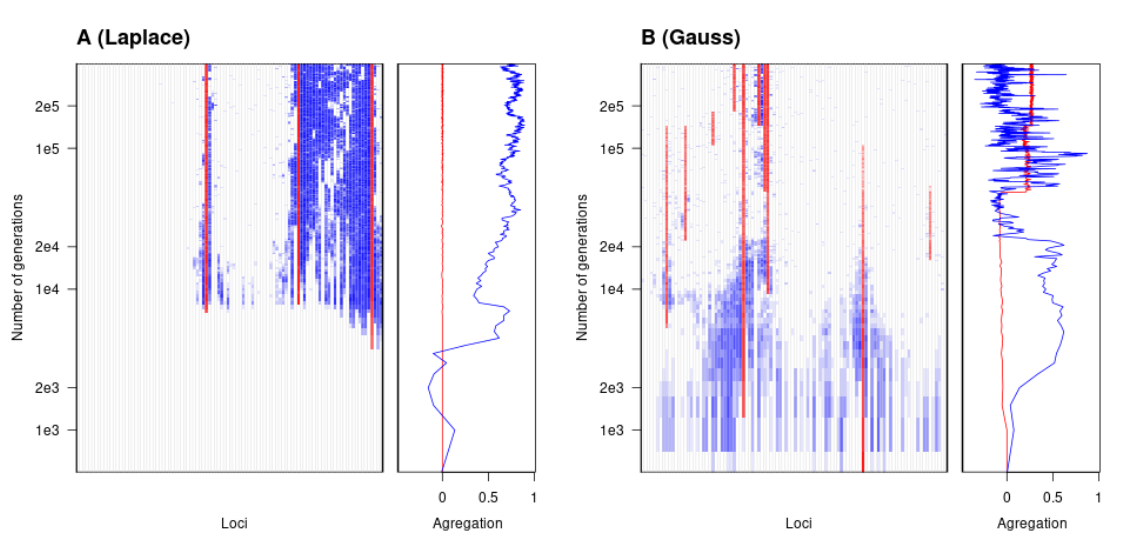
Figure 7 - Typical examples of aggregation dynamics with Laplace (panel A) and Gauss (panel B) fitness functions. In each panel, the frequency of the dominant adaptive allele at each locus within the central deme of habitat 2 is presented, in blue if it is an allele with a small effect size, red if it is a large effect size, with darker color for larger frequency. The x-axis “loci” represent loci, as they are ordered on the chromosome The evolution of the genetic architecture through time can be observed along the y-axis (in log scale, which allows presenting simultaneously the emergence and long term reconfiguration phases). Right next to these maps, we present how the aggregation metrics of small (blue lines) and large effect size alleles (red shapes) change in time. In the two examples, the width of habitat 2 is set to 𝑙 = 19 demes (which is between the swamping limits for small and large effect mutations in the Laplace case, see fig.